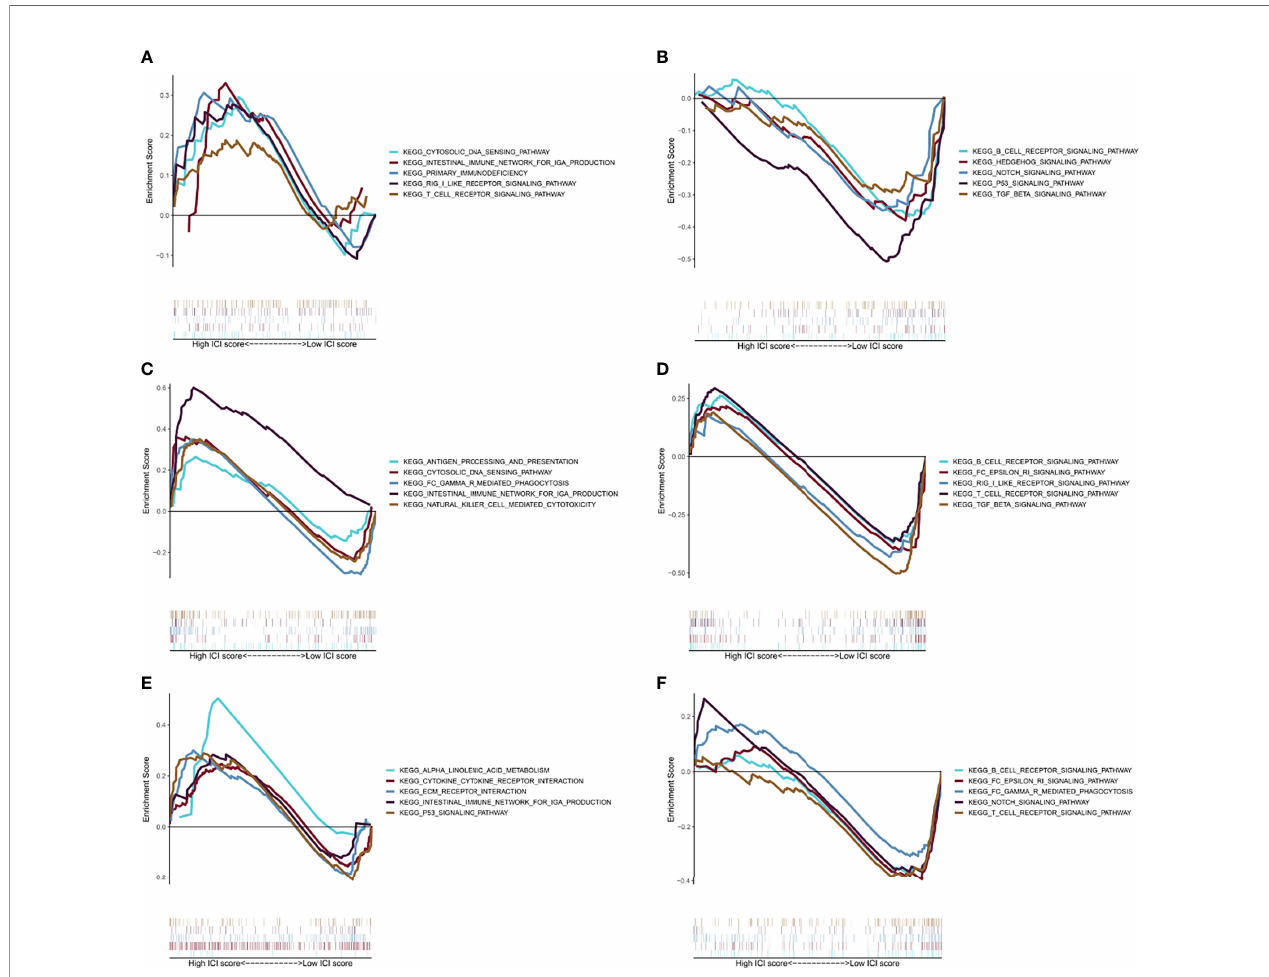
FIGURE 5 | GSEA analysis. (A) The fi rst fi ve results of the enrichment plots of tumors with high-risk scores by GSEA in the training cohort. (B) The fi rst fi ve results of the enrichment plots of tumors with low-risk scores by GSEA in the training cohort. (C) The fi rst fi ve results of enrichment plots of tumors with high-risk scores by GSEA in the testing cohort. (D) The fi rst fi ve results of enrichment plots of tumors with low-risk scores by GSEA in the testing cohort. (E) The fi rst fi ve results of enrichment plots of tumors with high-risk scores by GSEA in the TCGA-KIRC cohort. (F) The fi rst fi ve results of the enrichment plots of tumors with low-risk scores by GSEA in the TCGA-KIRC